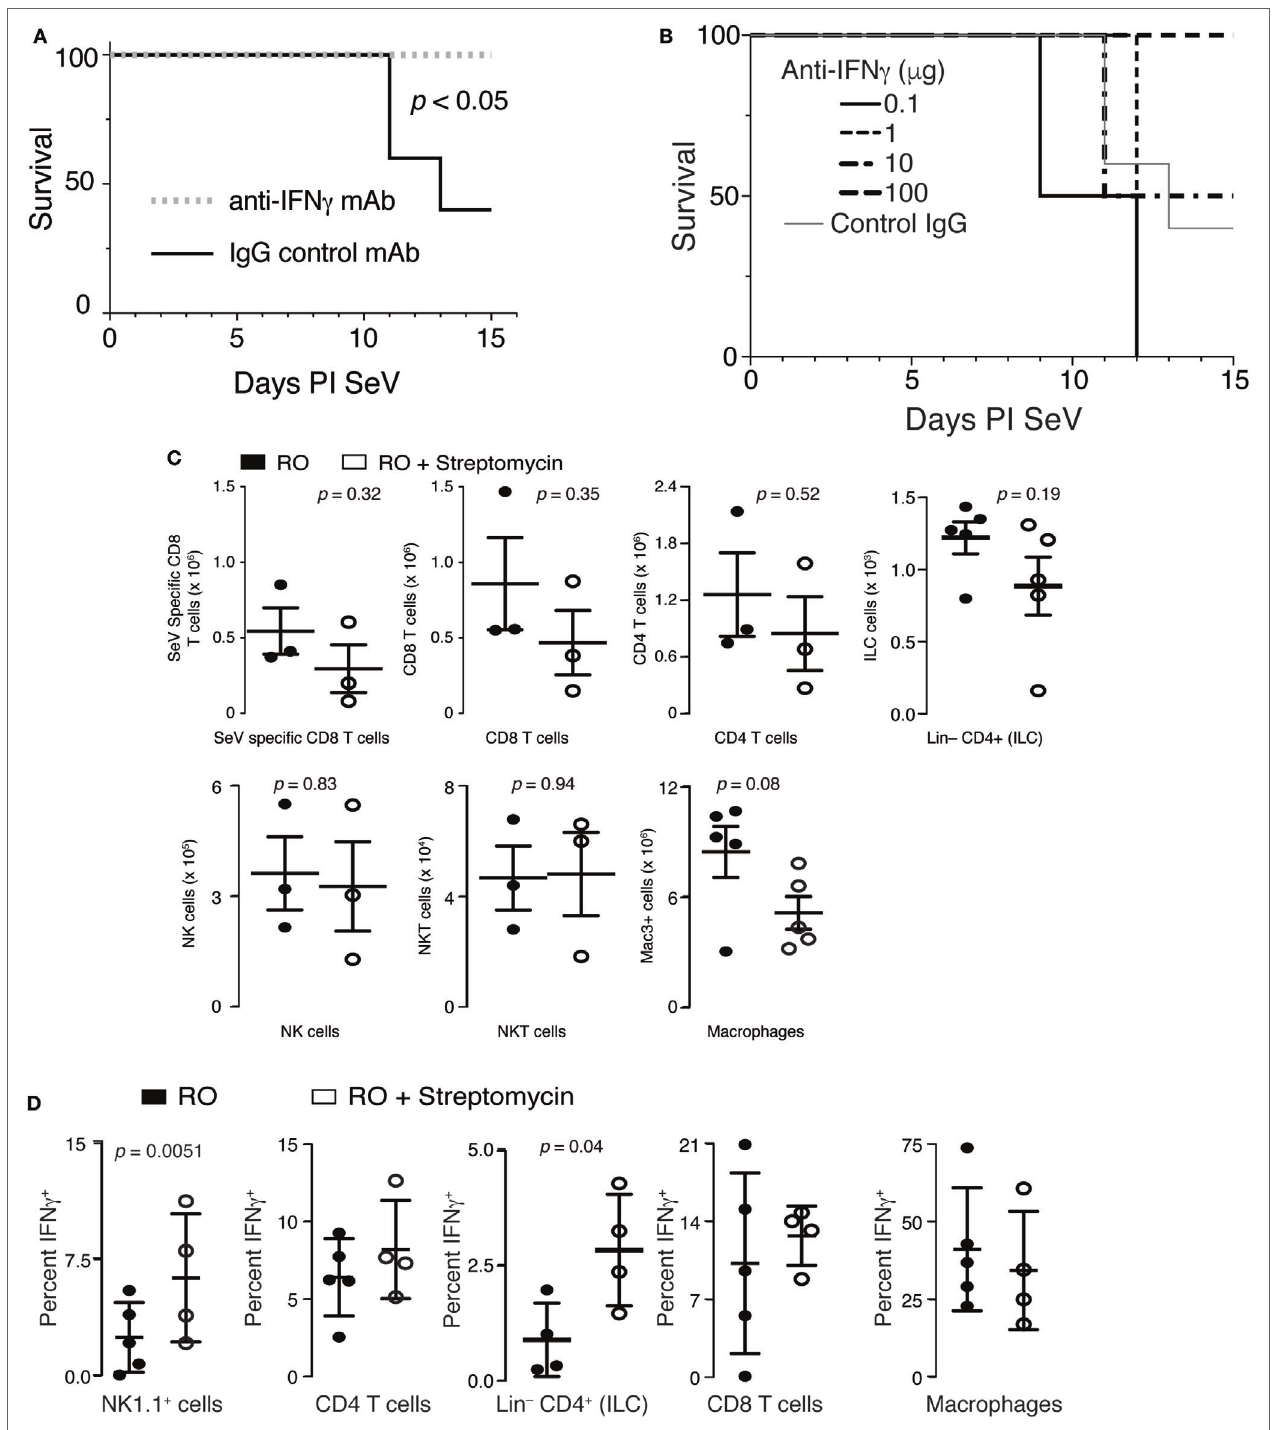
FigUre 5 | Increased mortality in streptomycin-treated mice is IFN γ dependent. (a) Mice were given streptomycin for 2 weeks before infection with Sendai virus (SeV). At day 5 and 9 PI SeV, 100 µg of an IFN γ blocking or control IgG monoclonal antibody was given SQ and mortality measured ( n = 5/group). (B) Mice were treated as in panel (a) but with the indicated doses of anti-IFN γ antibodies being administered ( n = 5/group). p < 0.04 for dose–response ( χ 2 ). (c) No difference was noted in the number of SeV-specific CD8 + T cells, total CD8 + T cells, total CD4 + T cells, NK cells (CD3 − NK1.1 + lymphocytes), NKT cells (CD3 + NK1.1 + lymphocytes), innate lymphoid cells (Lin − CD4 + lymphocytes), and macrophages (Mac3 + ) at 8 days PI SeV in the lungs of mice treated with reverse osmosis (RO) or RO + streptomycin ( n = 3–5 mice/group). (D) IFN γ from NK1.1, CD4, CD8-expressing lymphocytes, CD4 + Lin − cells, or lung Mac3 + macrophages was determined by intracellular flow cytometry on day 8 PI SeV. Mean ± SEM percent of given cell type expressing IFN γ is shown ( n = 4–10 mice/treatment/group). See Figure S1 in Supplementary Material for gating strategy.